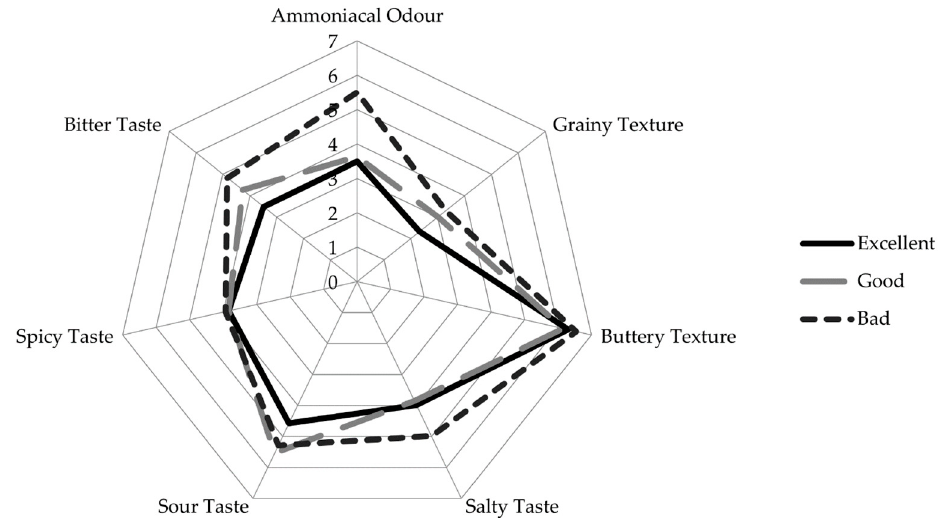
Figure 1. Radar graphic presenting some of the quantitative descriptive analysis (QDA) descriptors: odour (ammoniacal), texture (grainy and buttery) and taste (salty, sour, spicy and bitter) of cheese sensory characteristics. The cheeses belonging to the same sensory group (“Excellent”, “Good” or “Bad”, defined by the specialised trained panel scores) were grouped and the results were expressed as mean.